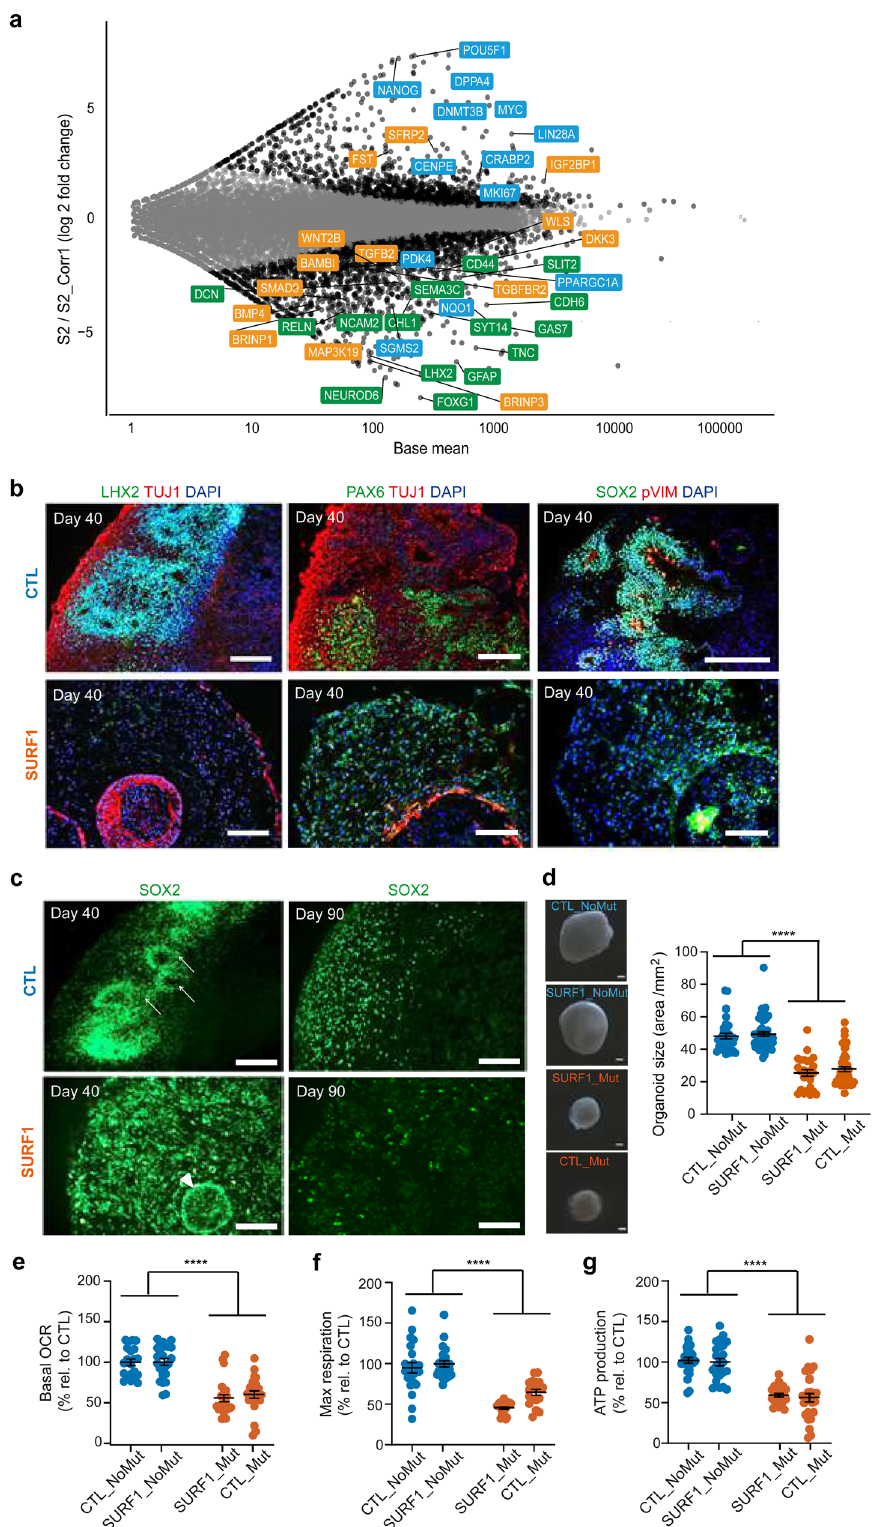
for the treatment of neurological and mitochondrial disorders 58,59 . Treatment of SURF1 NPCs with 400 µM BZ o.n. increased PGC1A protein content (Fig. 7g, i) and elevated mtDNA copy number (Fig. 7j). BZ treatment in SURF1 NPCs also lowered the expression of proliferative and pluripotency-associated markers ( c-MYC , OCT4 ) (Fig. 7k, l), and reduced cellular proliferation (Fig.